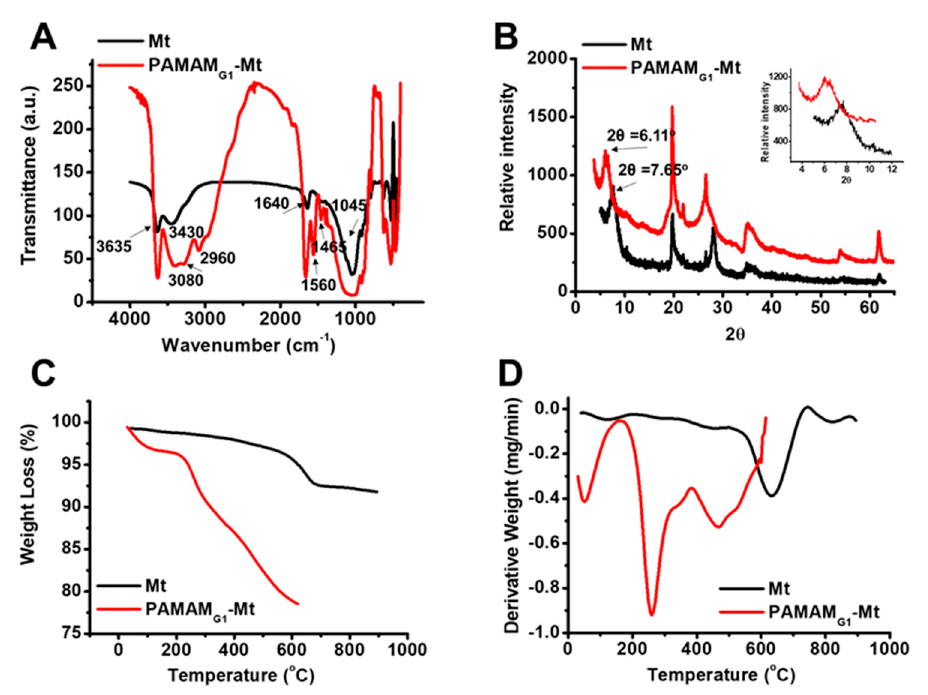
Figure 1. ( A ) Fourier transform infrared (FTIR) spectrum, ( B ) X-ray diffraction (XRD) pattern, ( C ) thermogravimetric (TG) analysis, and ( D ) differential thermogravimetry (DTG) thermograms of Mt and PAMAM G1 -Mt.